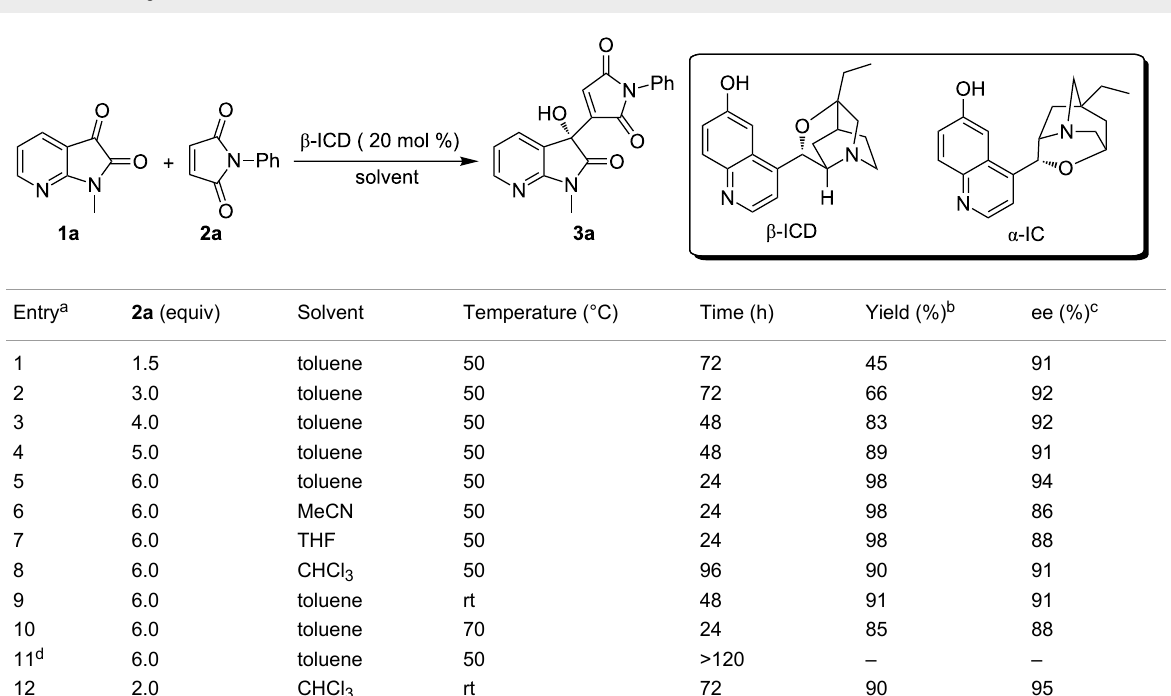
Table 1: Screening conditions of the enantioselective MBH reaction of 1a and 2a .